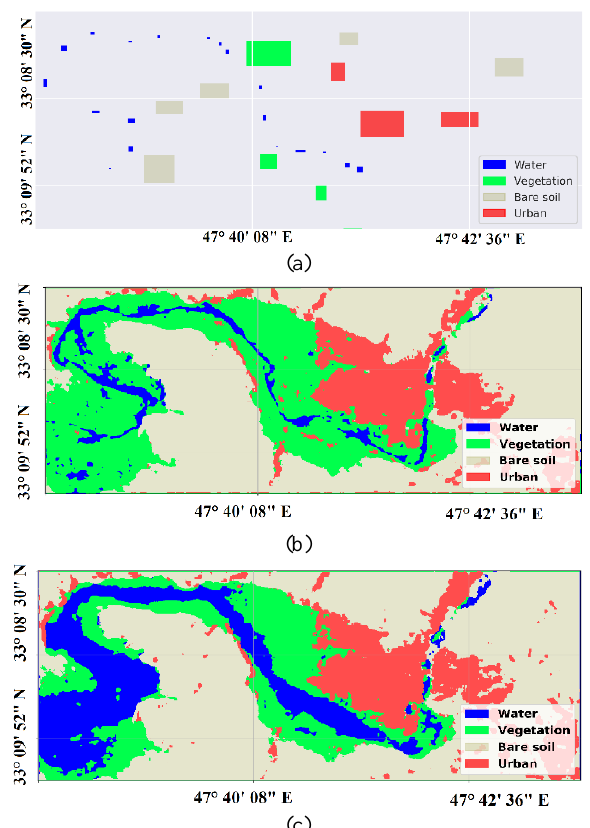
Figure 4. (a) Ground truth map and (b) Classified map of the study area before the flood (c) Classified map of the study area after flood